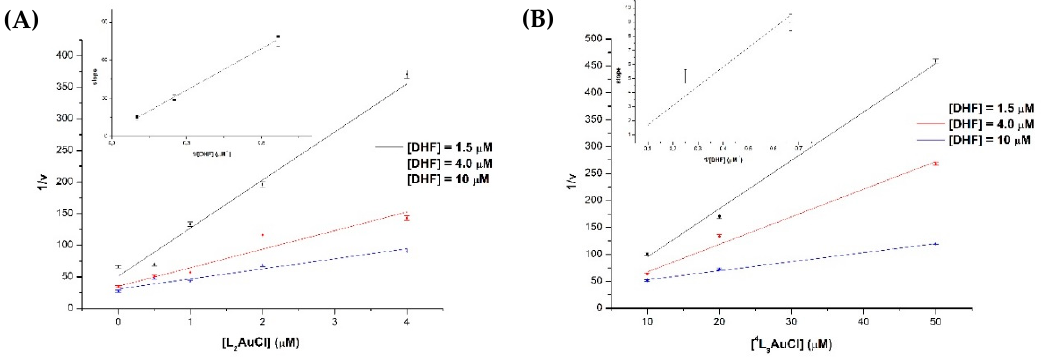
Figure 1. Dixon plot with the secondary plot in the inset for compound L 2 AuCl ( A ) and 4 L 3 AuCl ( B